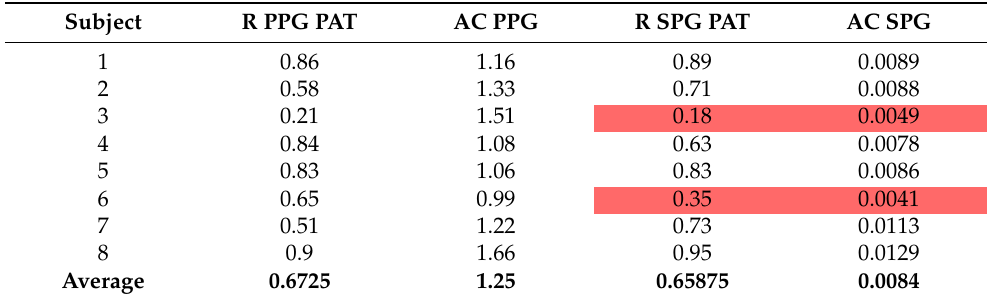
Table 1. R (correlation) of fiAP and PPG PAT vs. R of fiAP and SPG PAT. Red highlight shows signals below the 0.006 quality